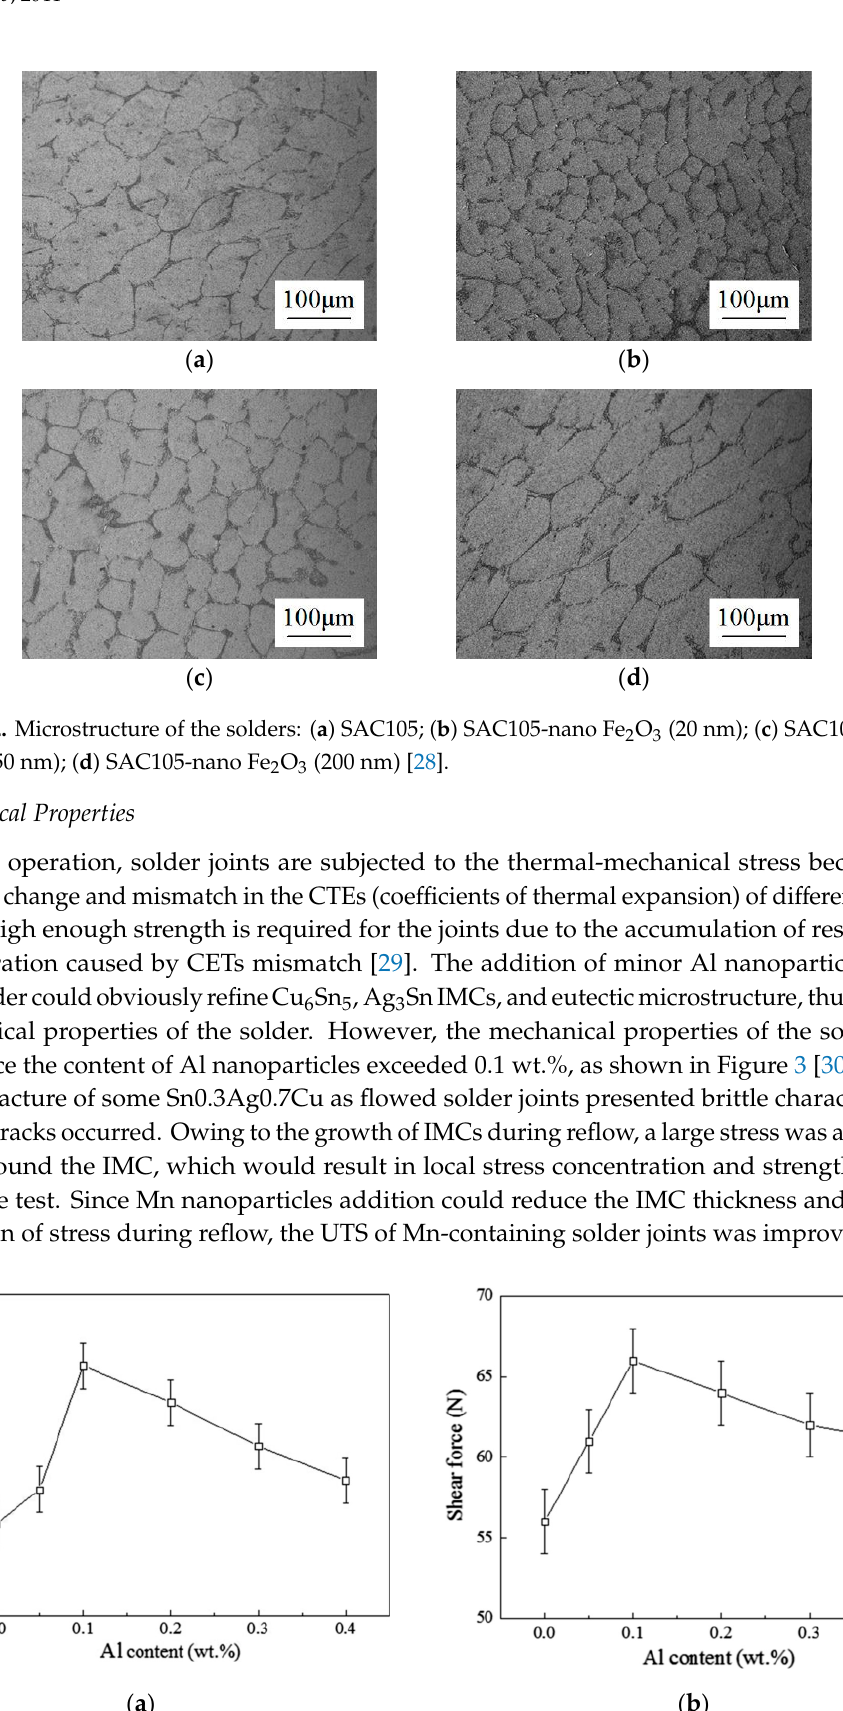
( f ) Figure 1. Field emission scanning electron microscope ( FESEM) image of SnAgCu–nano La 2 O 3 composite solder: ( a ) 0% La 2 O 3 ; ( b ) 0.01% La 2 O 3 ; ( c ) 0.03% La 2 O 3 ; ( d ) 0.05% La 2 O 3 ; ( e ) 0.1% La 2 O 3 ; ( f ) high-resolution image of (e) [23]. In the reflow process, a brittle interfacial layer is rapidly formed at the interface between the molten solder and the substrate; meanwhile, the overgrowth of intermetallic compounds (IMCs) will result in lower connecting strength of solder joints [24,25]. After multiple reflow, the coarsening of the Cu 6 Sn 5 layer occurs and the Cu 3 Sn layer is formed at the interface between the Cu 6 Sn 5 layer and the substrate, which decreases the reliability of the joints. Chan et al. [26] found that adding Zn nanoparticles could decrease the growth rate of Cu 6 Sn 5 and suppress the formation of Cu 3 Sn. Research [27] found that the grain size of Cu 6 Sn 5 IMC increased with the increasing reflow time, and TiO 2 nanoparticles could effectively suppress the growth of the IMC layer by preventing the diffusion of Cu and Sn atoms. Considering the effect of secondary phase particles on the migration of grain boundary during grain growth, the total restraining force acting on the boundary can be expressed as follows: b 3f γ = 2r F